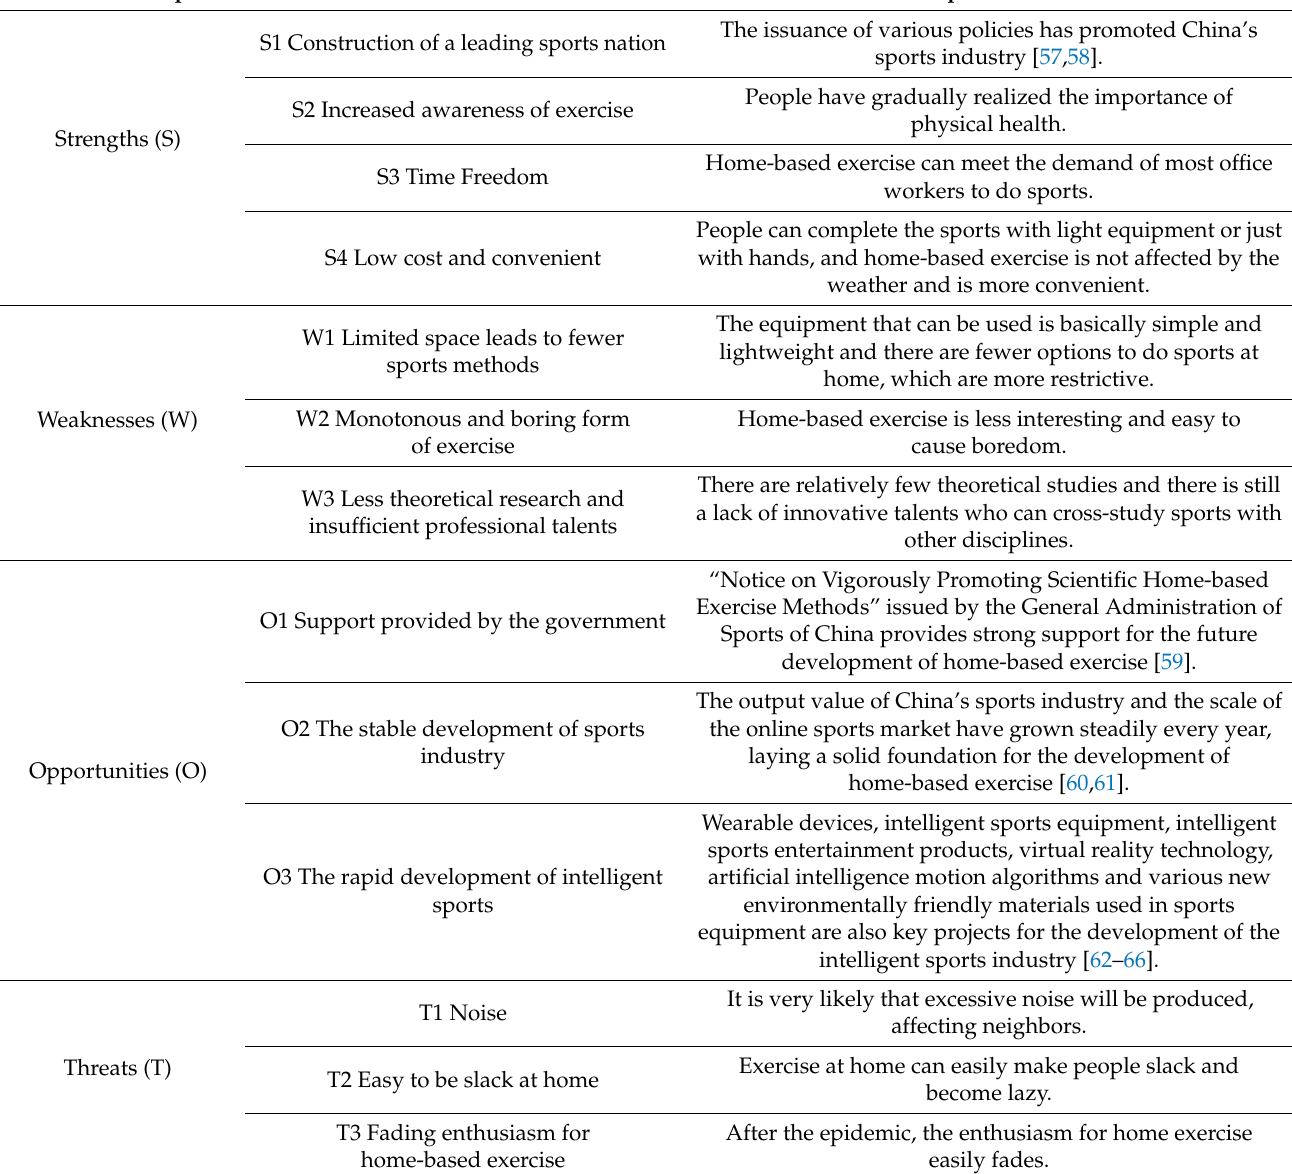
Table 1. Strengths, weaknesses, opportunities and threats-analytical hierarchy process (SWOT-AHP) factors and description. SWOT